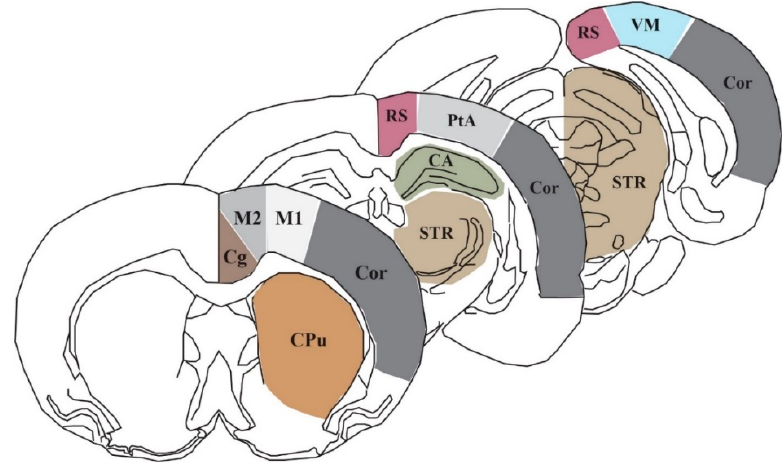
Figure 4. Schematic of three representative coronal sections (+0.7, − 3.8, − 7.3 mm relative to bregma) showing the 10 autoradiographic regions of interest: CA: cornu ammonis/hippocampus, Cg: cingulate cortex, Cor: cortical strip, CPu: caudate putamen, M1: primary motor cortex, M2: secondary motor cortex, PtA: parietal association cortex, RS: retrosplenial cortex, STR: striatum, and VM: visual cortex.